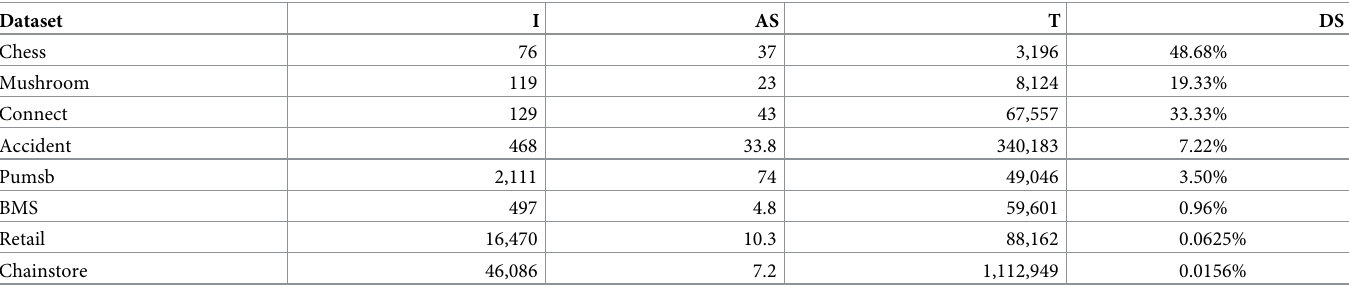
Table 3. Dataset